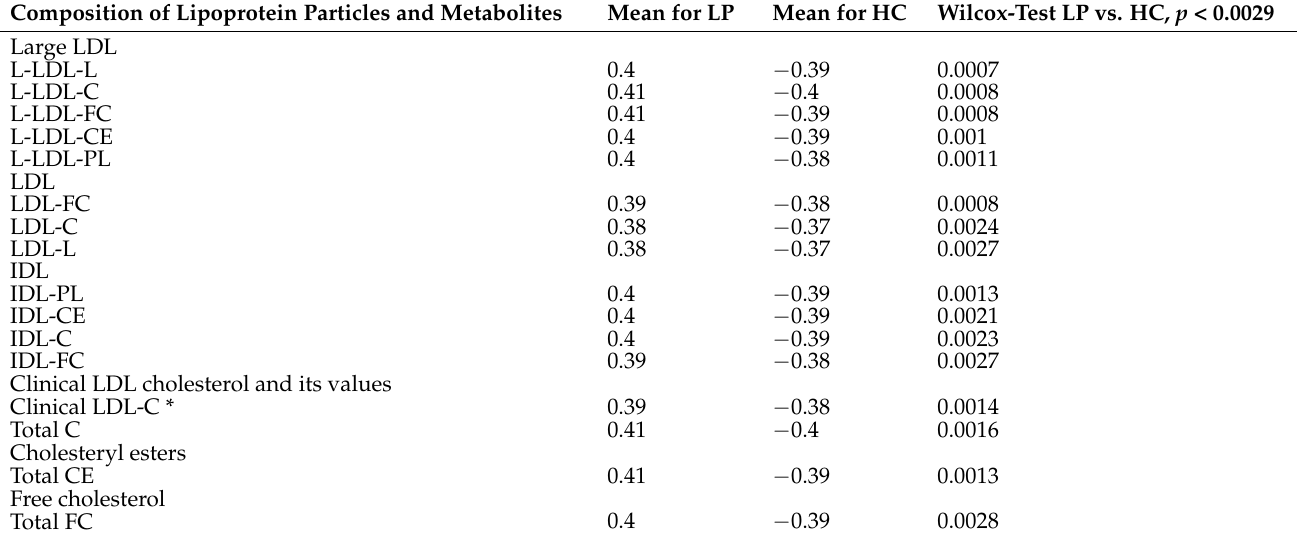
Table 1. Statistically significant differences in lipoprotein particles and metabolites between blood serum samples obtained from patients suffering from LP and